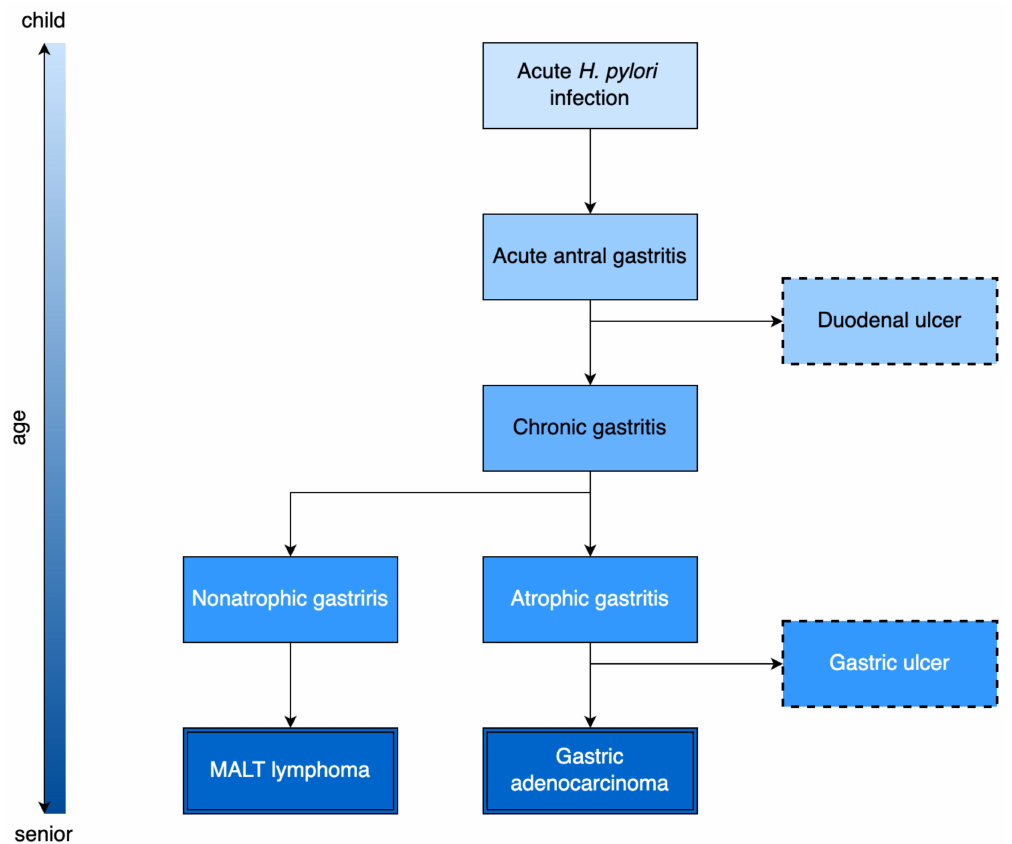
Figure 2. Timeline of clinical manifestations in patients infected with H. pylori